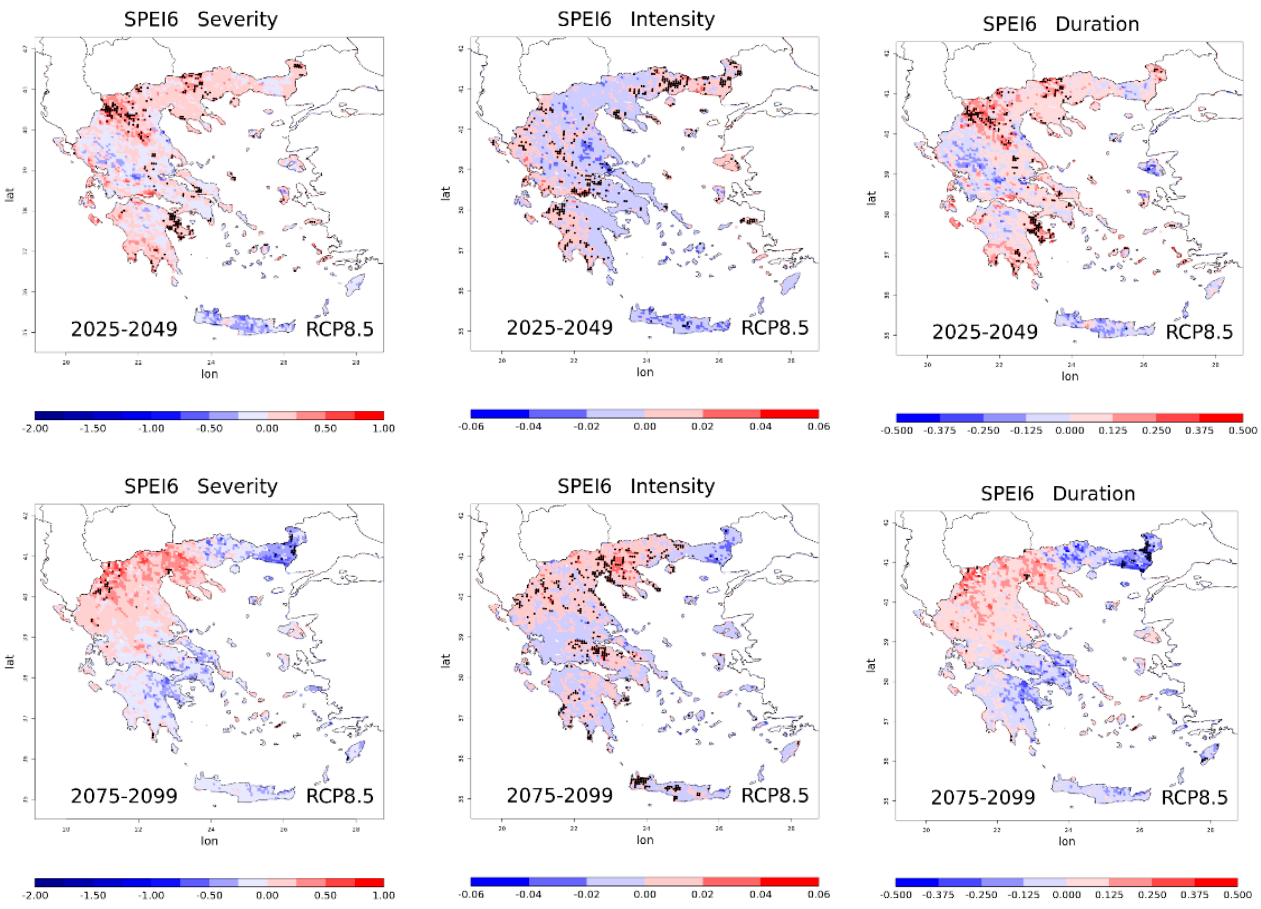
Figure 8. Trends of Severity ( left ), Intensity ( center ) and Duration ( right ) for the 6-month SPEI under RCP4.5 and RCP8.5 for the period 2025–2049 and 2075–2099. The black dotted areas show significant changes in the drought characteristics at the 5% significance level.